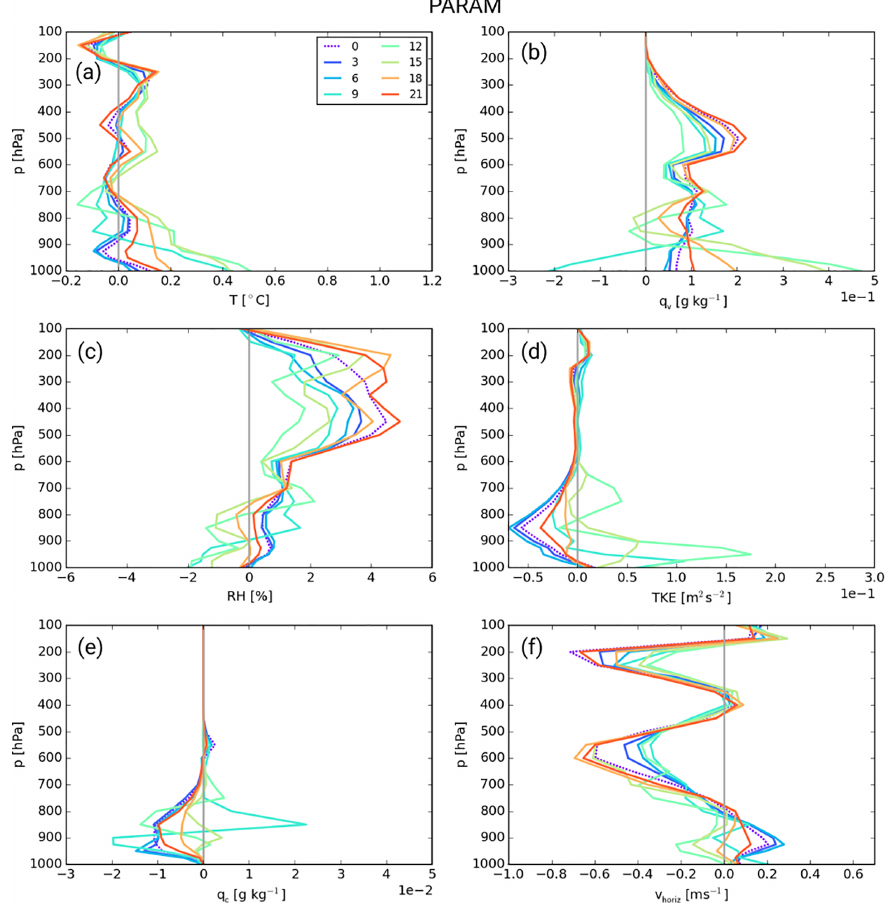
Figure 8. As Fig. 7 but for PARAM.